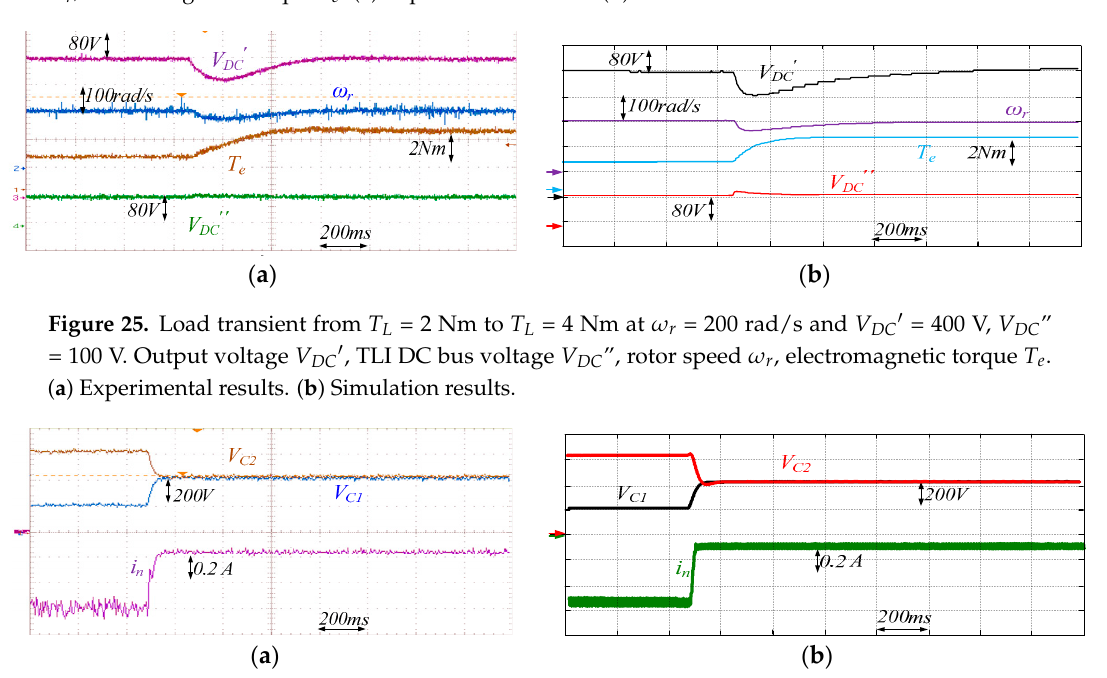
Figure 26. DC bus voltage balancing: T L = 4 Nm, ω r = 200 rad/s and V DC '= 400 V, V DC '' = 100 V. V c1 , V c2 and i n . ( a ) Experimental results. ( b ) Simulation results. Table 7. Errors between experimental results and those obtained with the averaged-value model.